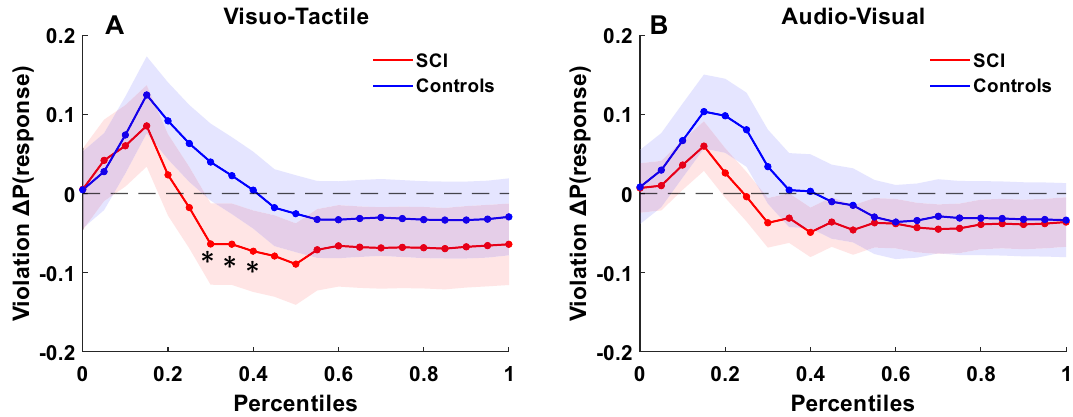
Figure 3. Race model violations (for the fastest RTs (40%)): Figure shows violations in Visuo-Tactile ( A ) and Audio-Visual ( B ) conditions for each group (red lines represent SCI participants, blue lines healthy controls) measured as the difference (Δ) in the CDFs between bimodal and the correspondent race (known as Miller’s Inequality). Positive values (above 0) denote the multisensory enhancement effect. Color shade indicates standard deviation. (* p <